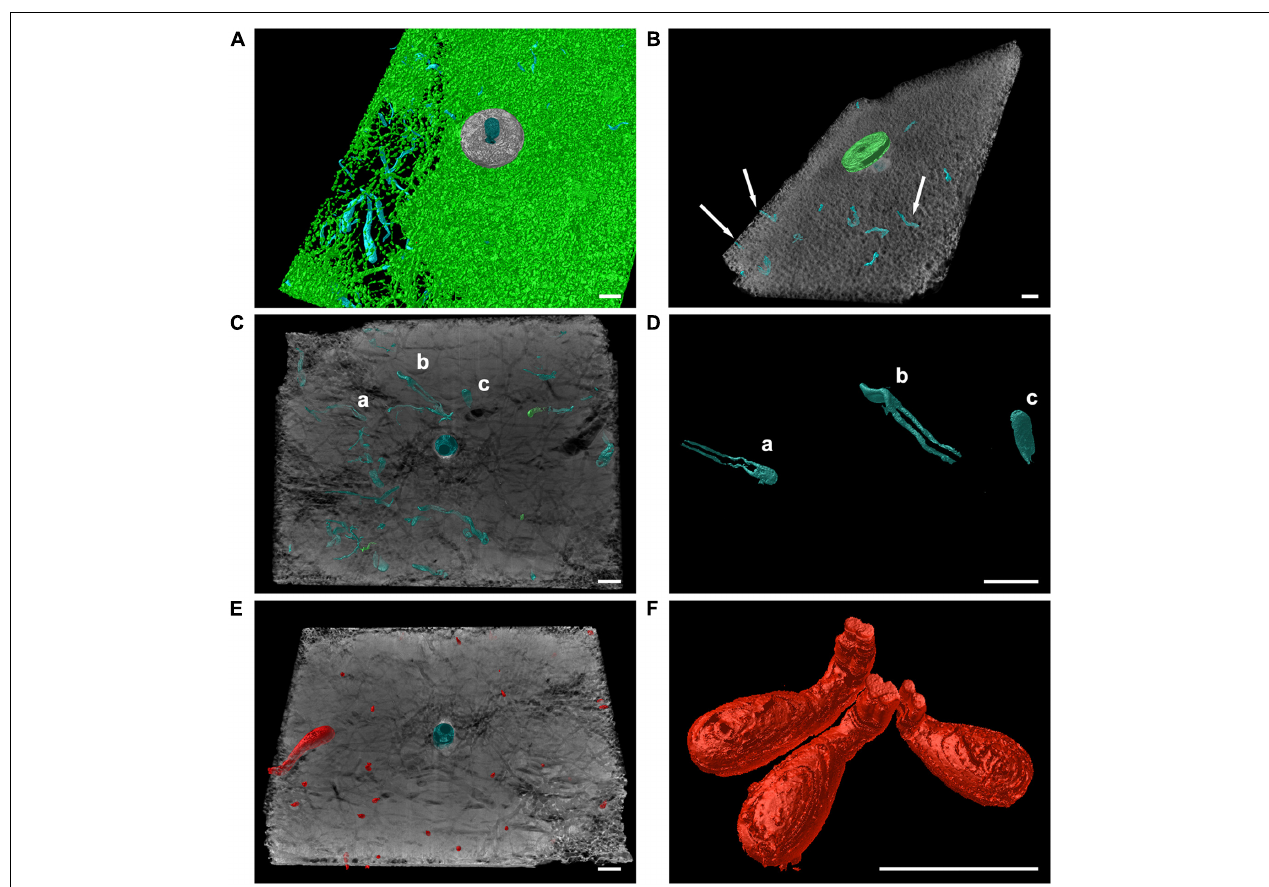
FIGURE 7 | Computed tomography graphic reconstruction of burrowing worms and endolithic bivalves’ traces in travertine tiles. (A) Caulostrepsis traces, in blue, surrounded by Entobia cf laquei traces, in green, at MR08 after 12 years. (B) Burrowing worms traces’ ( Trypanites traces indicated by arrows), in blue, at MR08 after 12 years. (C,D) Maeandropolydora traces ( Maeandropolydora cf decipiens Voigt, 1965; a, b and c, in blue) at P213 after 12 years. (E) Gastrochaenolites traces at P213 after 12 years, in red. (F) Detail of Gastrochaenolites traces at P204 after 12 years. Scale bars are 1 cm